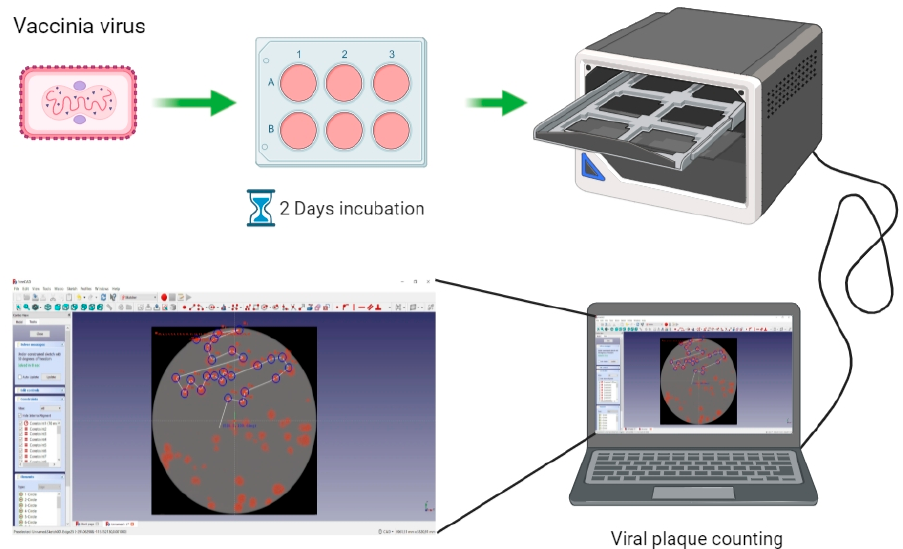
Figure 5. Workflow of VACV titer determination based on the fluorescence-dependent plaque assay.